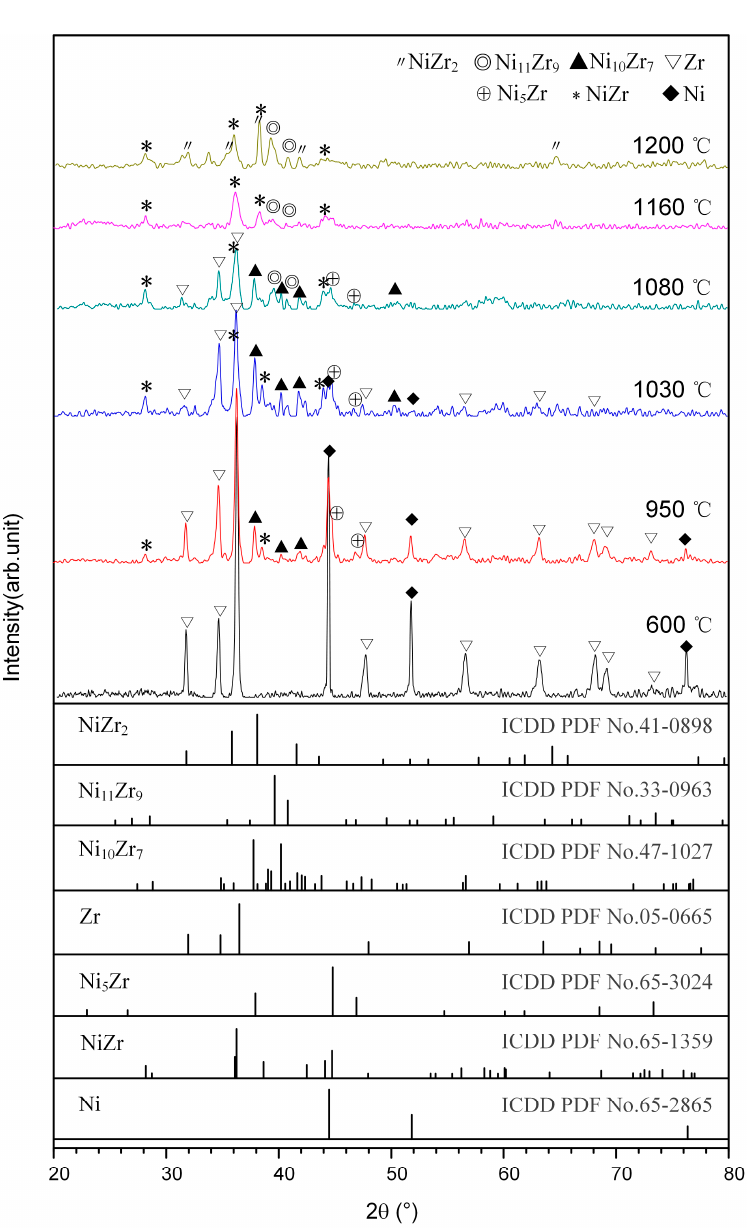
Figure 4. XRD patterns for the DSC products of Ni-Zr mixtures quenched at different temperatures.